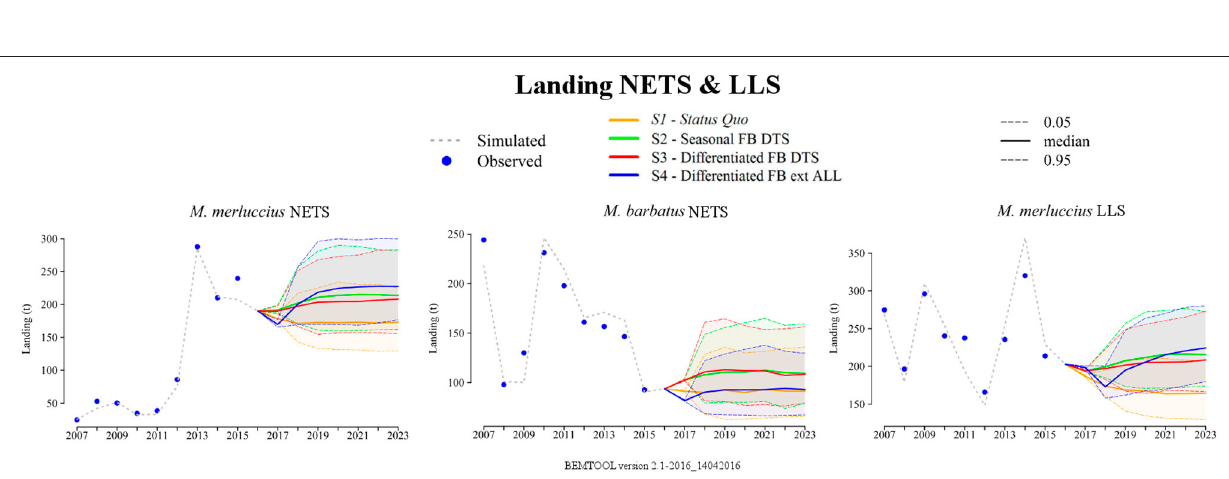
Frontiers in Marine Science |